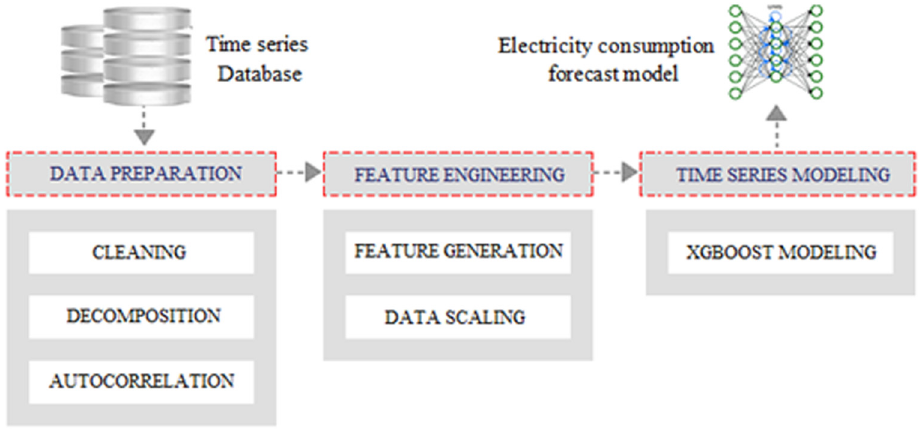
Figure 1: Proposed forecasting electricity consumption